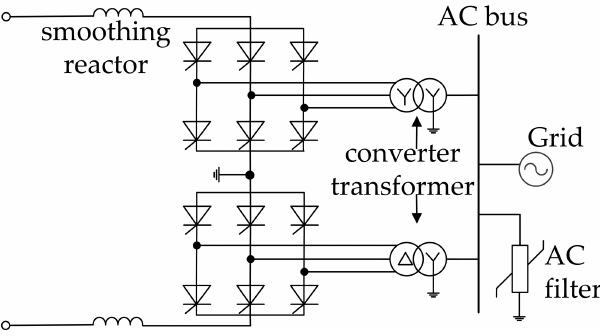
Figure 4. Structure of the line commutated converter station.